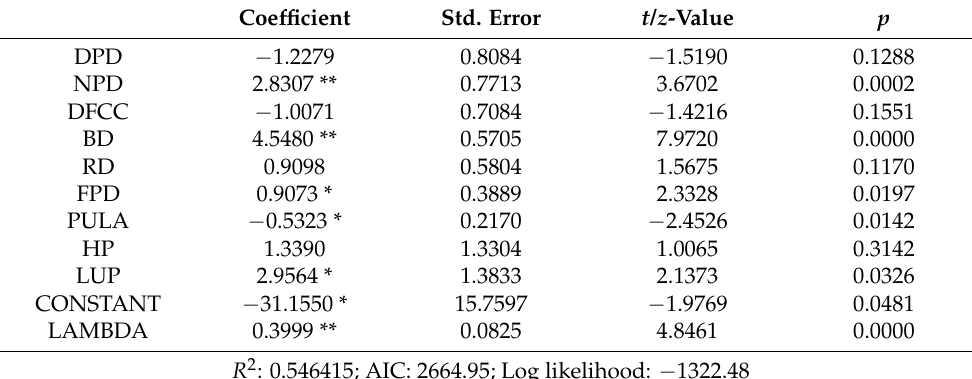
Table 4. SEM model